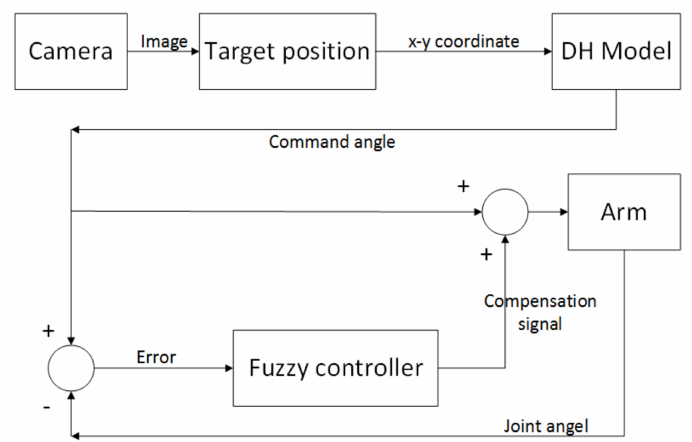
Figure 23. Position control scheme with LM-HLP and fuzzy